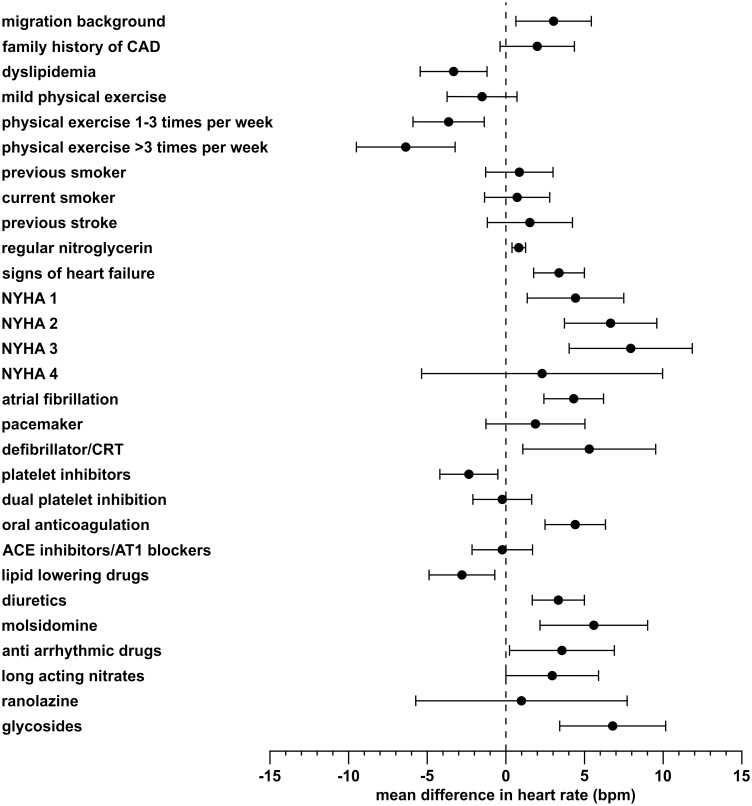
Regression estimates and confidence intervals of simple models analyzing predictors of heart rate using variables that were unique to the ProCor II dataset.